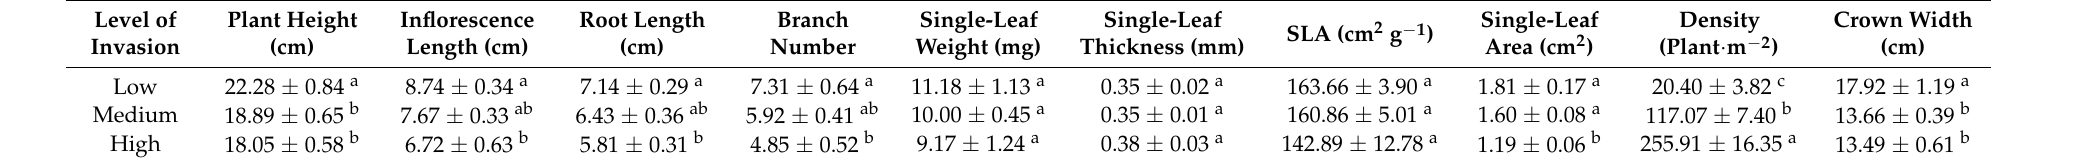
Table 1. Morphological characteristics of Pedicularis kansuensis in different invasion levels.